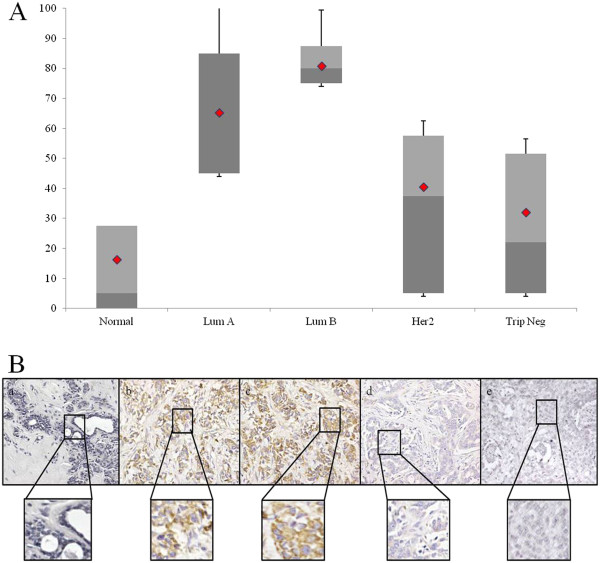
Gadd45A expression levels in human breast cancer samples are dependent on the hormone receptor subtype. (A) Box and Whisker Plots graphically depict the expression pattern of Gadd45a in the subtypes of human breast cancer. There was a highly significant difference in percent Gadd45a staining between groups: Normal 16.3%; Luminal A 65.3%; Luminal B 85.7%; HER2+ 40.5%; TN 31.2%, P < 0.001, ANOVA. (B) Representative images from immunohistochemical analysis of Gadd45a of Normal (a), Luminal A (b), Luminal B (c), Her2+ (d) and Triple Negative (e) breast tissue. Immunostaining was reviewed and scored by three independent observes. Percent positive stainings for each specimen were averaged and categorized as: Negative (0- < 10%, Neg), Low (10–<40%), Medium (40–<70%, Med), or High (≥70%).